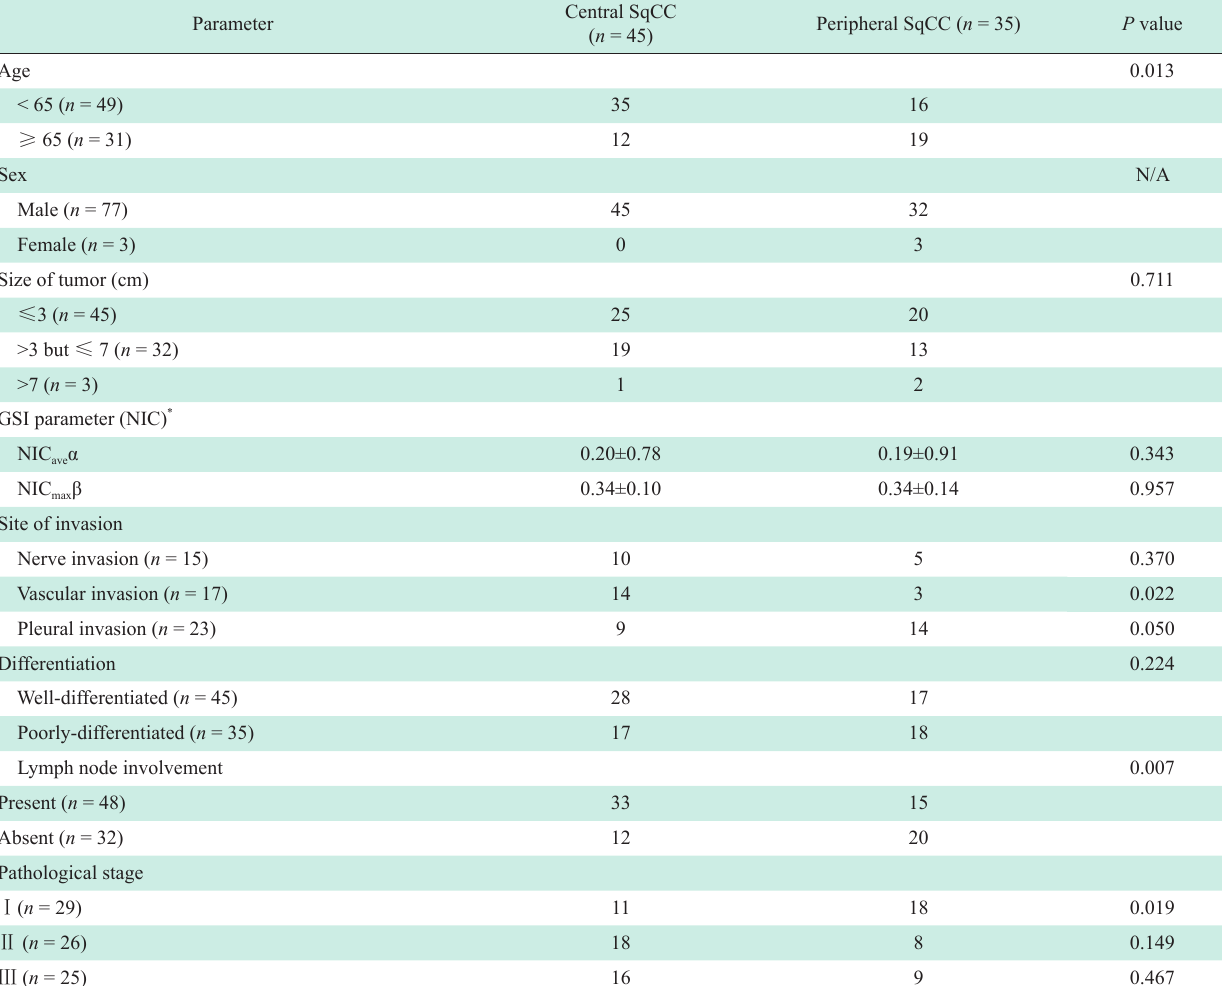
Table 2 Difference of clinicopathological characteristics between the patients with central and peripheral SqCC in 80 patients